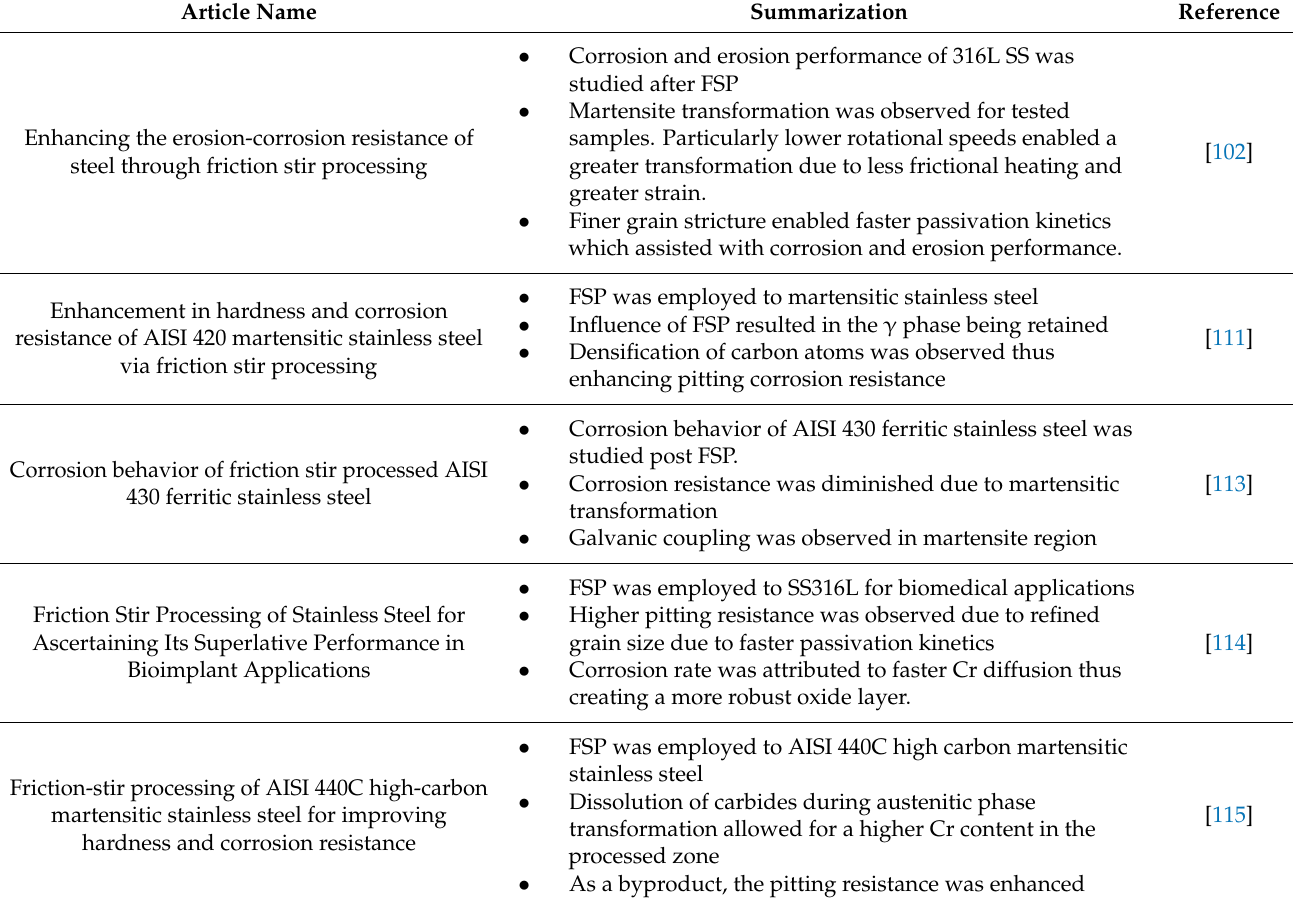
Table 2. Publications relating to corrosion and erosion refinement of FSP